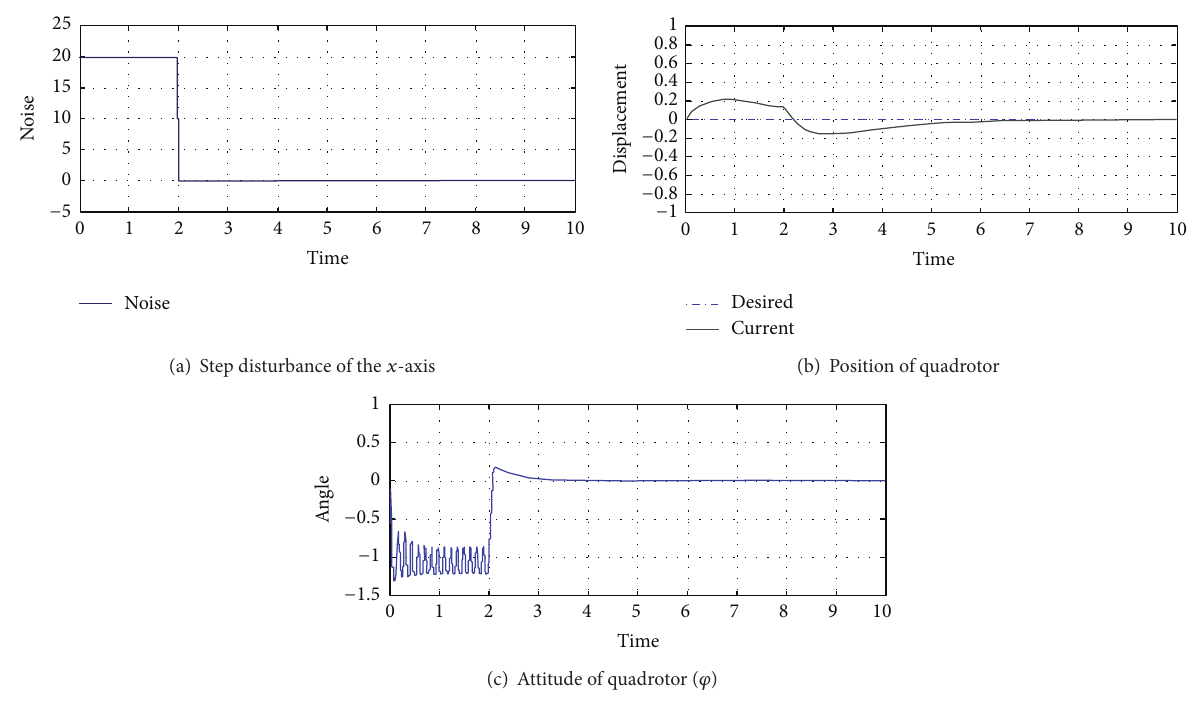
Figure 11: Results for the full system (disturbance